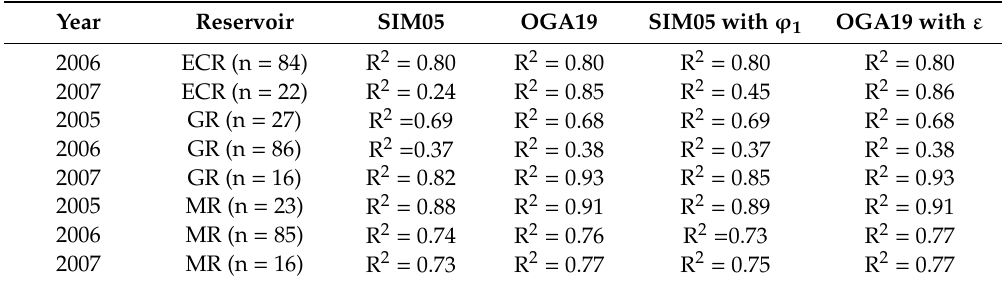
Table 7. Calibration for SIM05 and OGA19 using simulated OLCI